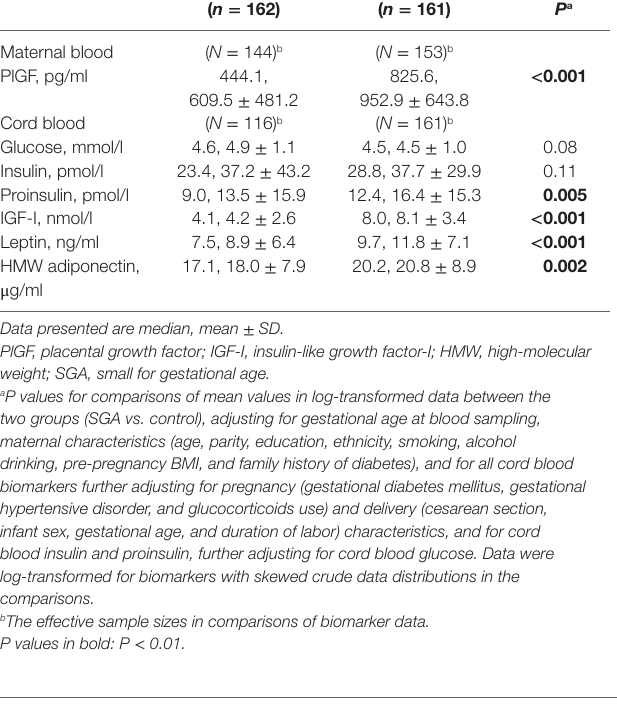
There were no significant interactions between SGA status and maternal PlGF in relation to neonatal metabolic health biomarkers in infants (regression tests for interactions, all TaBle 2 | Plasma concentrations of maternal blood PlGF (32–25 weeks of P > 0.1). Therefore, the correlations were reported for all gestation) and cord blood biomarkers in SGA and control infants. study subjects together (rather than for SGA and control sga control adjusted infants separately). Adjusting for gestational age at blood ( n = 162) ( n = 161) P a